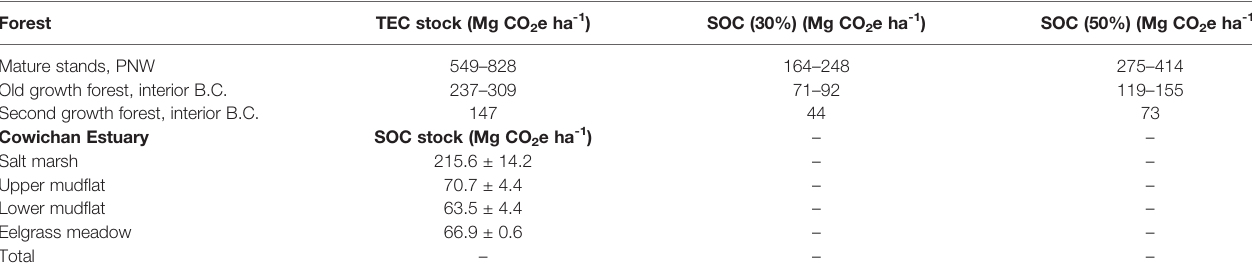
TABLE 5 | Comparison of sediment organic carbon (SOC) stocks, reported as carbon dioxide equivalents (CO 2 e), in the top 1 m of Cowichan Estuary salt marsh and eelgrass meadow, mature stands in the Paci fi c Northwest (PNW), old- and second-growth forests of interior British Columbia, Canada. Forest Mature stands,